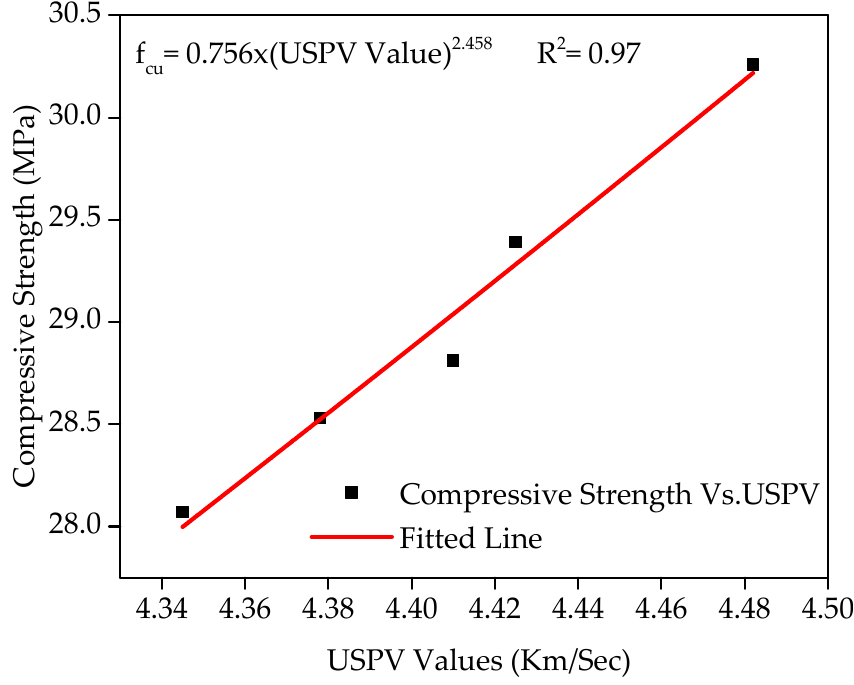
Figure 13. Relationship of compressive strength versus USPV.